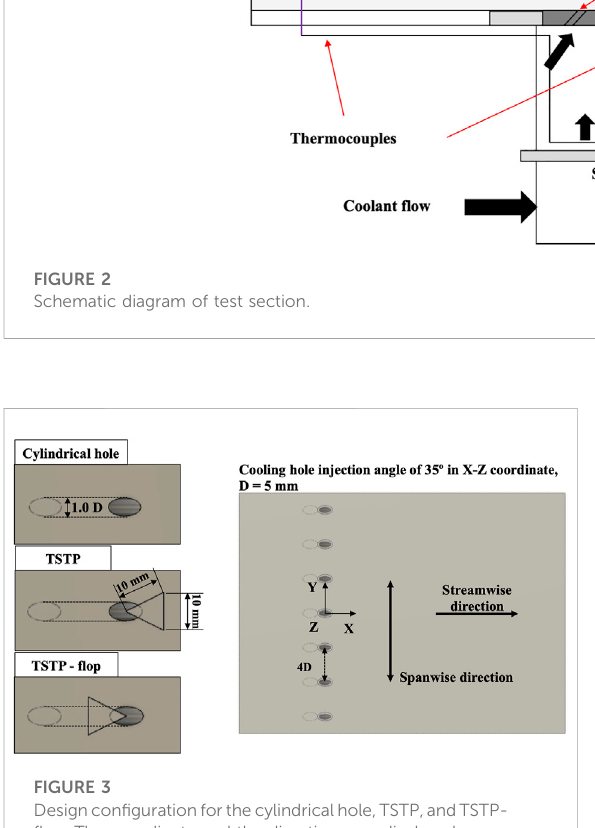
Figure 3. A test plate with a thickness of 15 mm was fabricated